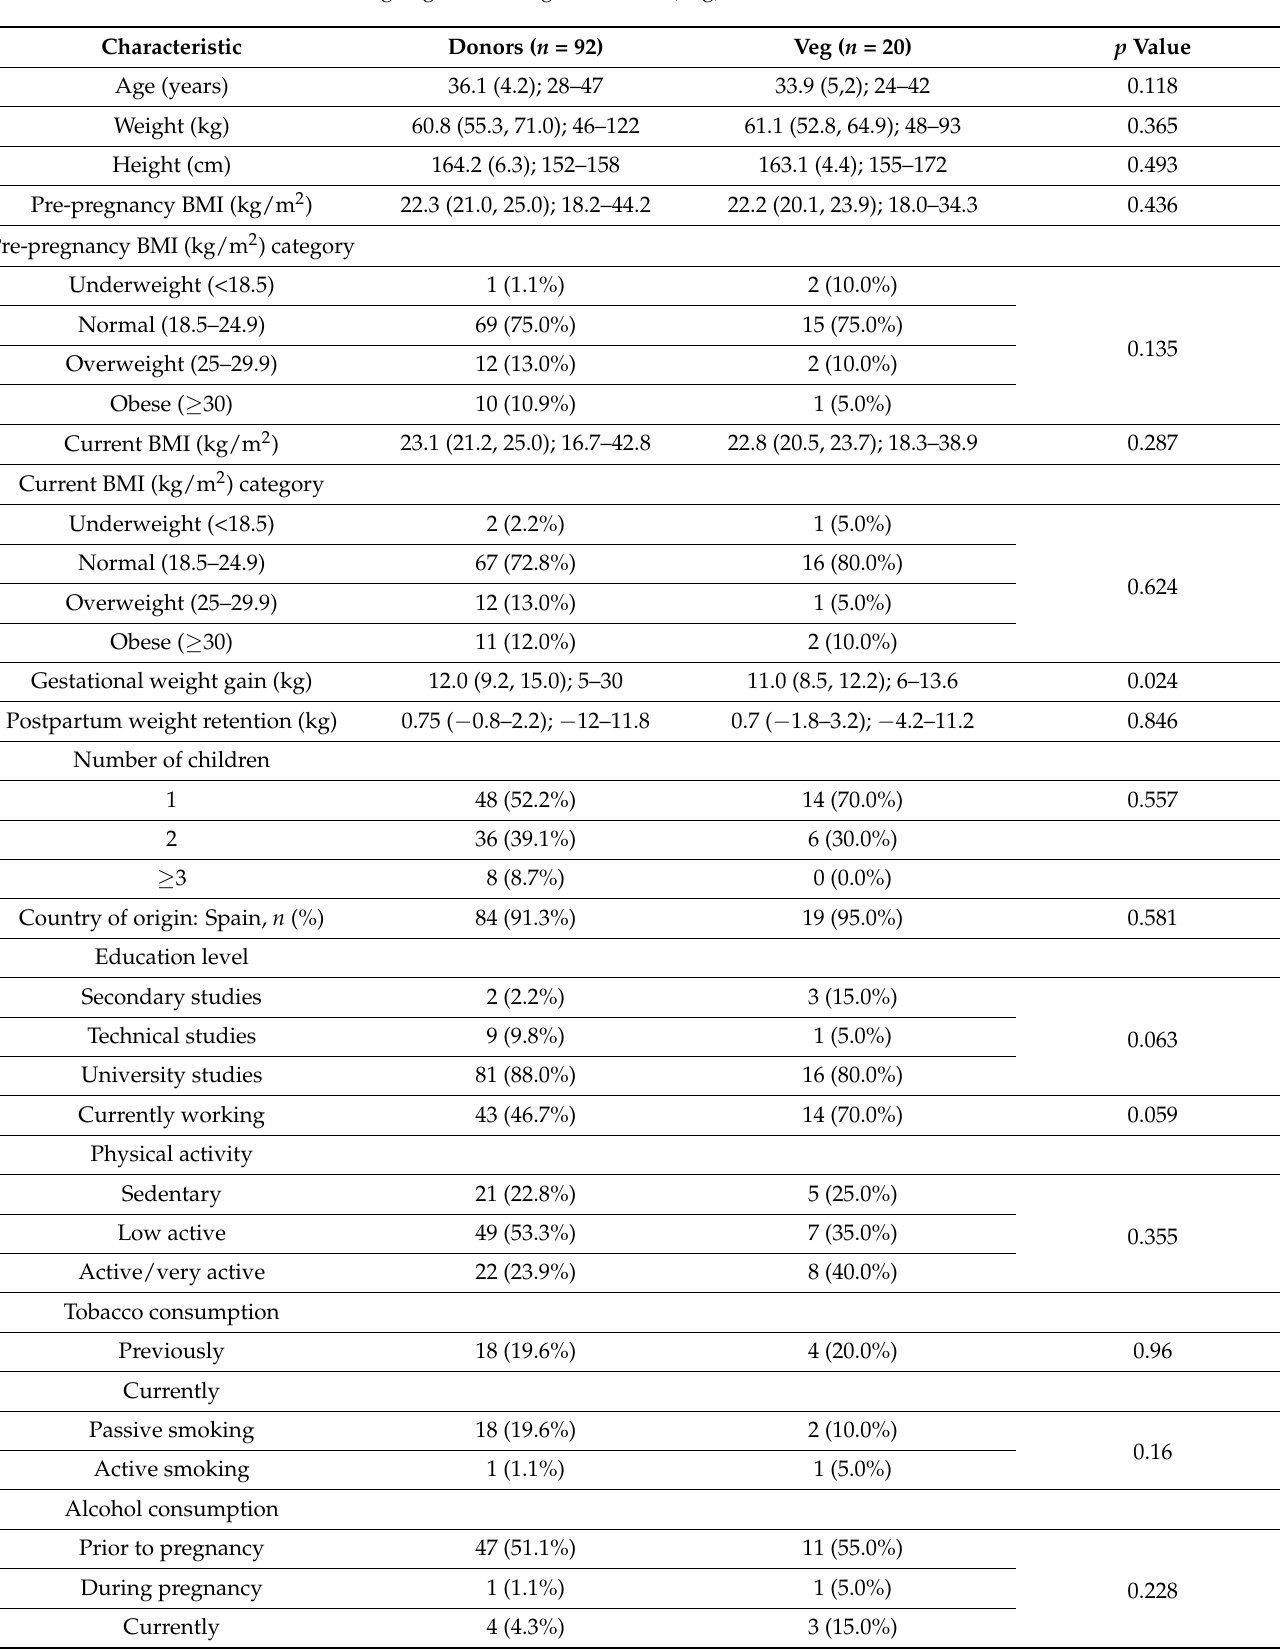
Table 1. Characteristics of the omnivore human milk donors with full-term infants (Donors) and lactating vegetarian/vegan mothers